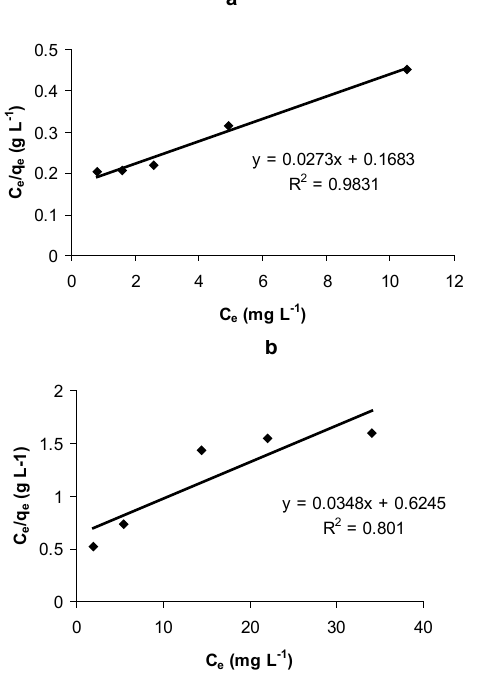
Figure 6. Langmuir adsorption isotherms of Pb(II) ions onto (a) PASAC and (b) ZASAC.